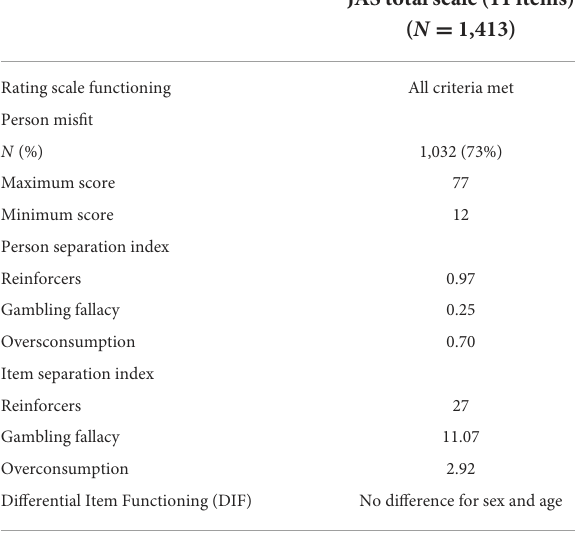
TABLE 3 The psychometric properties of Jonsson Abbott